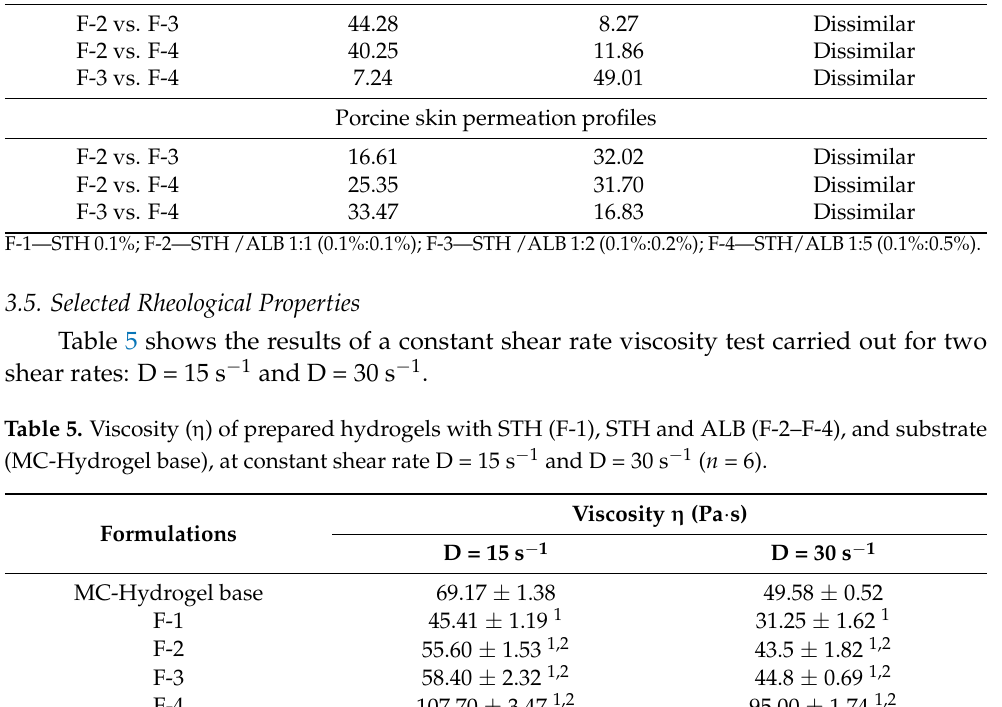
Formulations F-1 F-2 Permeation Profile Cellulose membrane permeation profiles